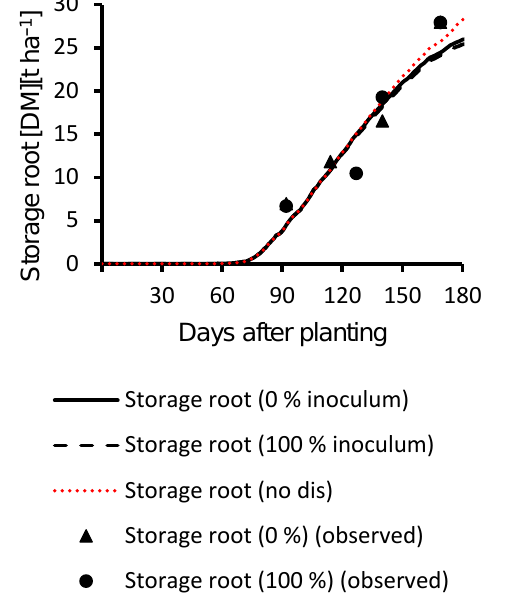
Figure 10. Simulated and observed values (2017): storage root weight (DM t ha − 1 ) for the evaluation treatment with (0% inoculum, 100% inoculum) and without (“no dis”) simulated Cercospora leaf spot disease damage ratings included in the simulation.